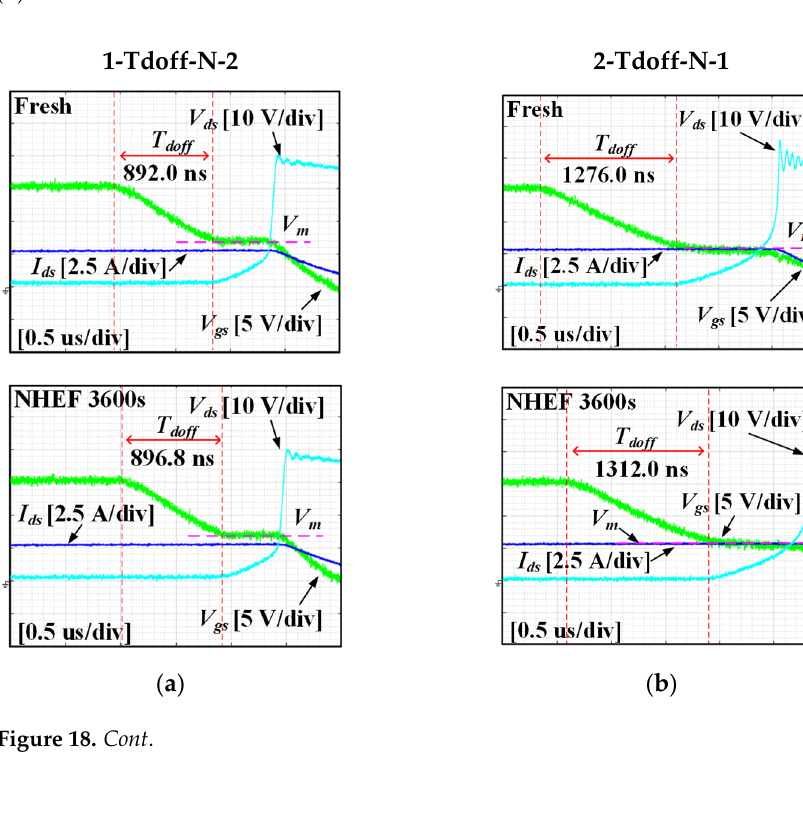
Figure 17. T doff variations in PHEF stress: ( a ) Si IGBT, ( b ) Si MOSFET, ( c ) Si IGBT with SiC diode, and ( d ) SiC MOSFET.